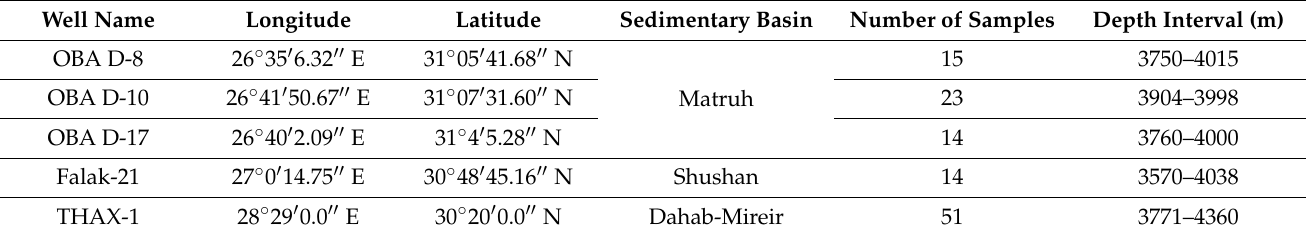
Table 1. Longitudes and latitudes of the current study wells in the north Western Desert as well as the number of representative samples selected from the Khatatba Formation in each